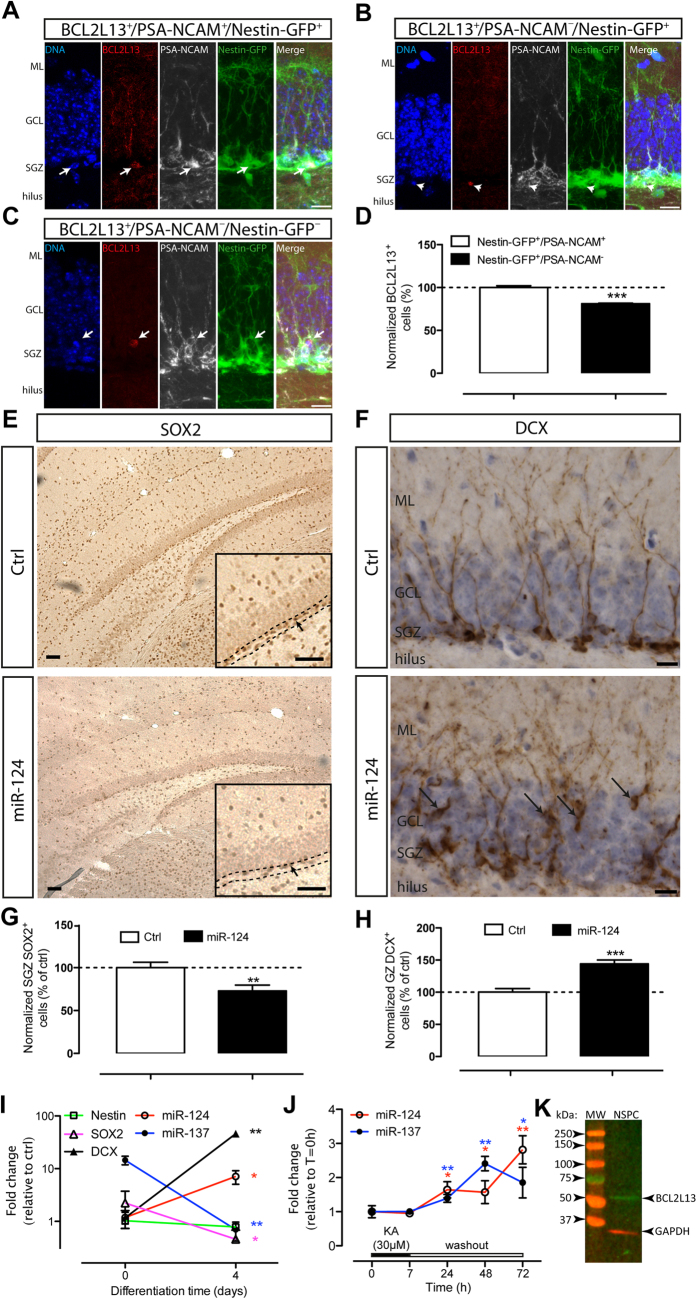
BCL2L13 expression in the DG and hippocampal NSPC cultures.(A) Representative confocal image displaying BCL2L13+/PSA-NCAM+/Nestin-GFP + cells present in the SGZ (arrows). (B) Representative confocal image displaying BCL2L13+/PSA-NCAM-/Nestin-GFP + cells present in the SGZ (arrowheads). (C) Representative confocal image displaying BCL2L13+/PSA-NCAM-/Nestin-GFP- cells outside the SGZ (arrows). (D) Quantification of BCL2L13 protein expression in Nestin-GFP + cell populations of the DG (***p < 0.001). (E) SOX2 + cells 7 days after infusion with a NT-miR (Ctrl, top) or miR-124 (bottom). Insets: black arrowheads indicate SOX2 + cells within the SGZ, dotted lines indicate the limits of the SGZ. (F) DCX + cells 7 days after infusion with a NT-miR (Ctrl, top) or miR-124 (bottom). Black arrows: ectopic DCX + cells in the GCL. (G) Quantification of SOX2 + cells in the SGZ 7dpi with a NT-miR (Ctrl) or miR-124 (**p < 0.01). (H) Quantification of DCX + cells in the GZ 7dpi with a NT-miR (Ctrl) or miR-124 (***p < 0.001). (I) RNA expression of cell markers and miRs in hippocampal NSPC cultures, (SOX2, *p < 0.05; miR-137, **p < 0.01; DCX, **p < 0.01; miR-124, *p < 0.05; Nestin, p > 0.05). (J) miR-124 and miR-137 expression in hippocampal NSPC cultures during and after treatment with 30 μM KA, (*p < 0.05 and **p < 0.01, relative to time = 0). (K) BCL2L13 protein expression in hippocampal NSPC cultures. Left lane: molecular weight marker (MW), right: BCL2L13 and GAPDH. Data in bar graphs represent mean normalized numbers of immunoreactive cells (% of Nestin-GFP + /PSA-NCAM + or Ctrl) ± SEM from three animals. ML: molecular layer, GCL granular cell layer, SGZ: subgranular zone, GZ: granular zone containing areas GCL + SGZ, dpi: days post injection. Scale bars represent 10 μm (A–C and F) or 50 μm (E).